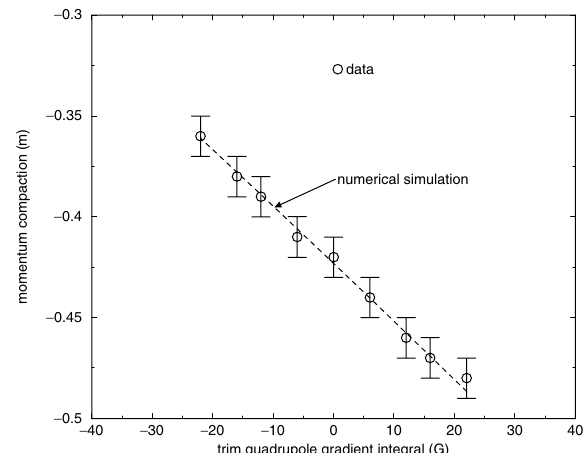
FIG. 11. Comparison between the expected and measured , for the whole recirculation linear momentum compaction, R 56 transport, versus different settings for one of the trim quadru- pole pairs in one of the 180 (cid:4)